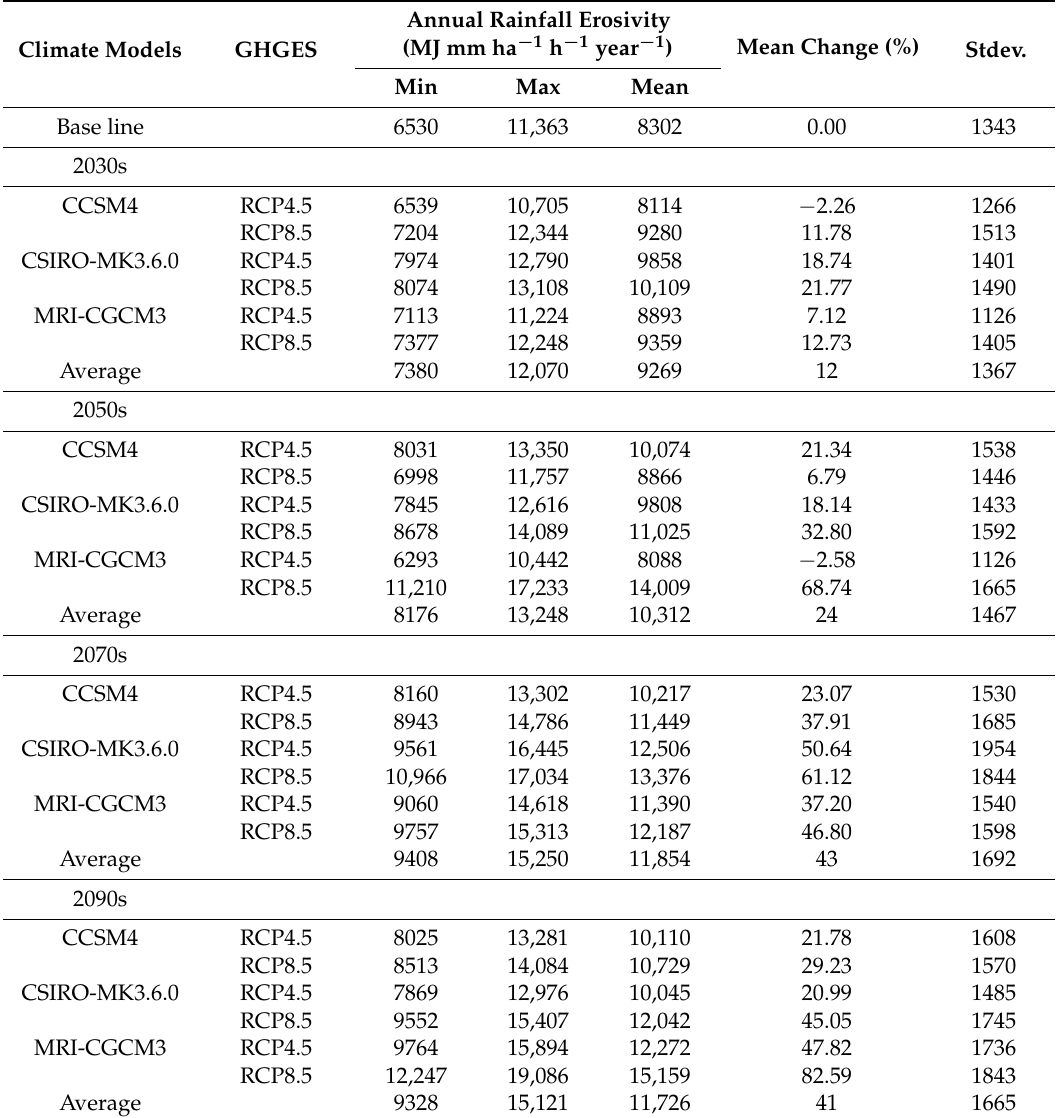
Table 7. Annual rainfall erosivity and percent change for all climate projections compared to the base period